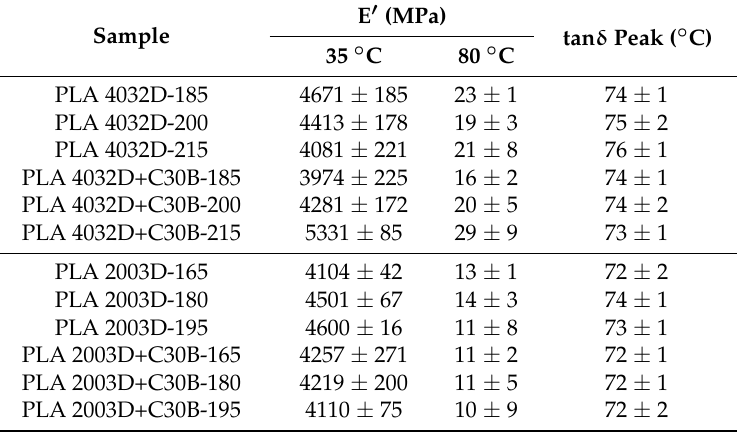
Table 7. Tan δ and storage modulus (dual cantilever mode) of PLA and PLA/clay 3D printed specimens at 35 and 80 ◦